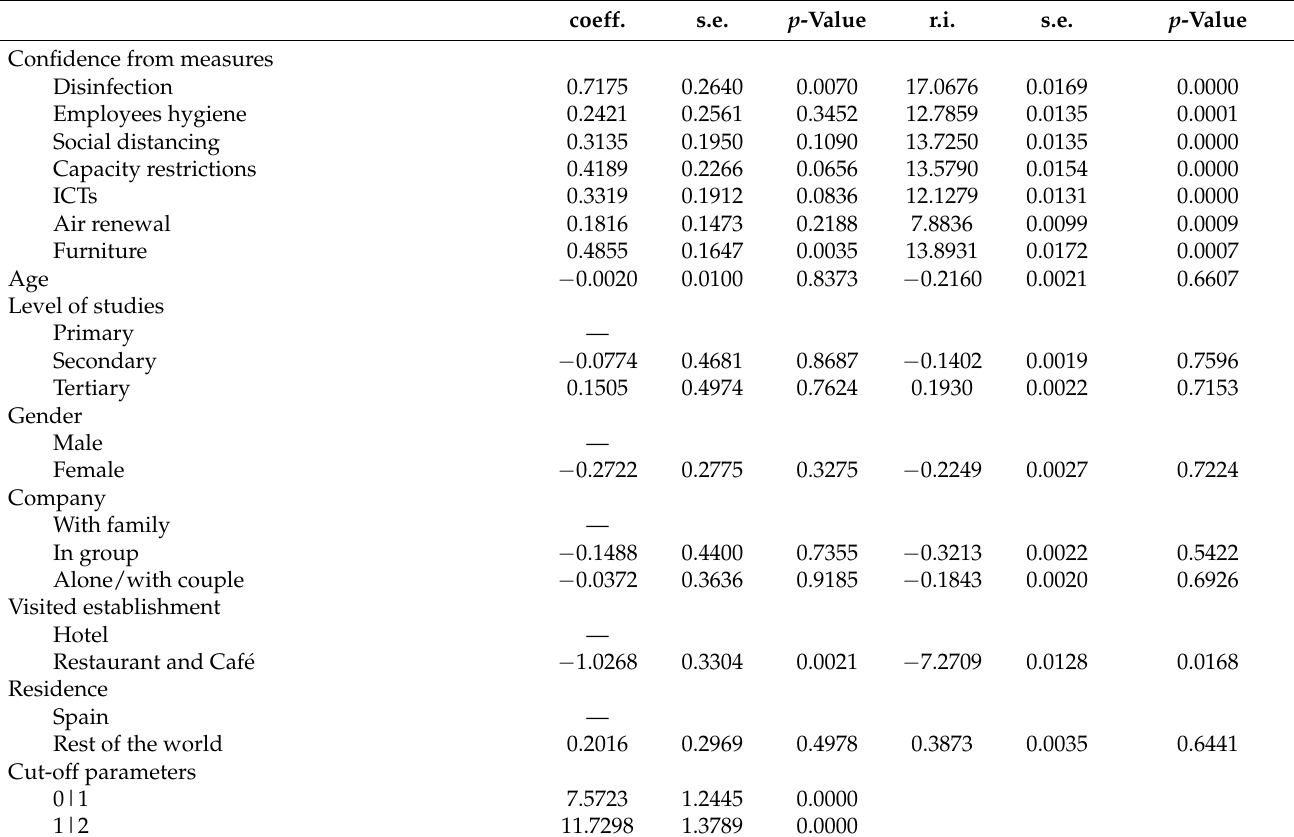
Table 6. Ordinal logit model for consumers’ overall satisfaction.